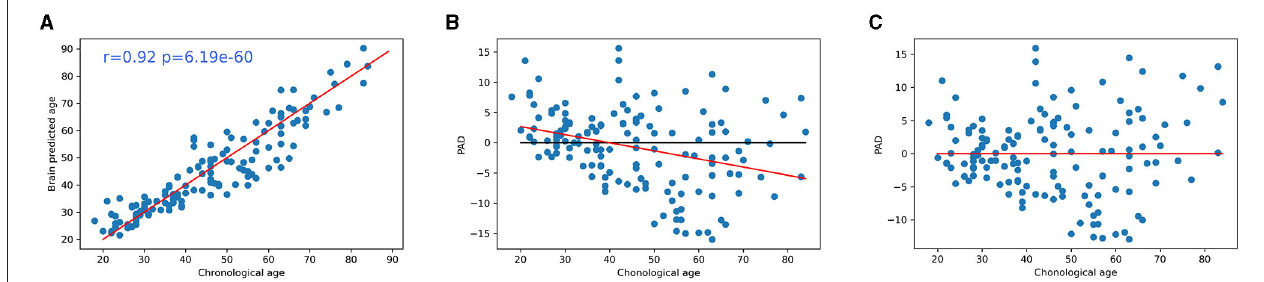
FIGURE 4 | (A) Accuracy of CNN for brain age prediction using testing set. Scatter plots depict chronological age (x-axis) and brain-predicted age (y-axis) on the testing set subjects. The r value was the Pearson’s correlation coefficient of brain-predicted age with chronological age and p was the associated p -value. Plot of the chronological age in function to PAD z-score (B) before and (C) after regression. CNN, convolutional neural network; PAD, predicted age difference.